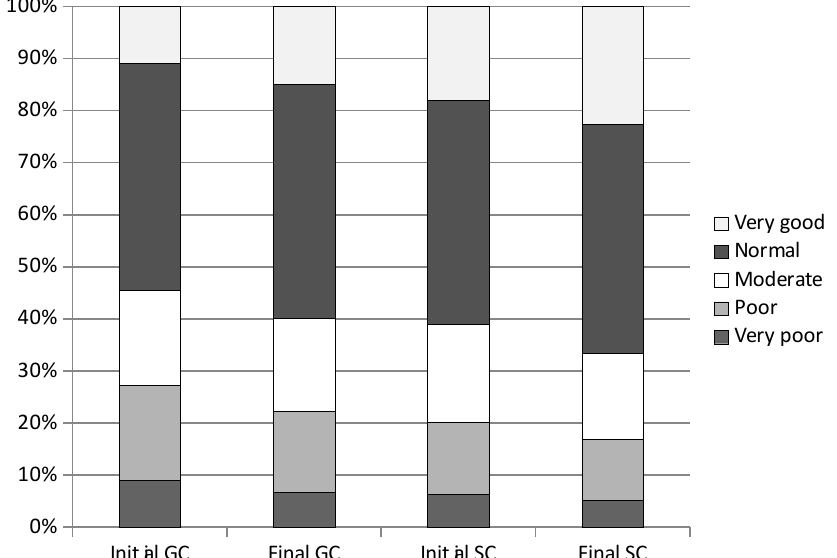
Figure 7. Comparison of children’s general physical fitness between the initial and final measurements. GC—general education classes; SC—sport classes.